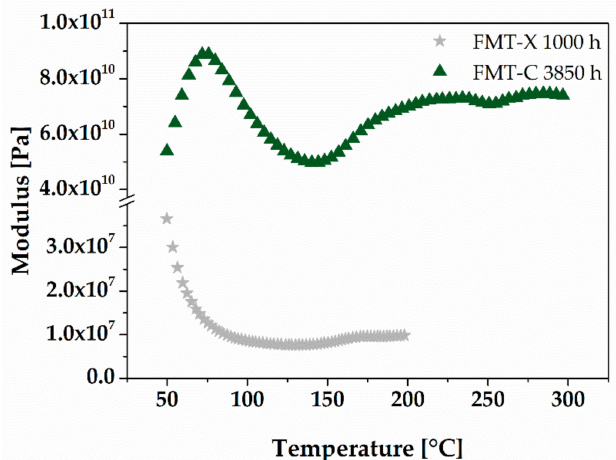
Figure 10. Dynamic properties of FMT-C after EoT (3850 h) and a MEA (FMT-X) of the same membrane chemistry after 1000 h